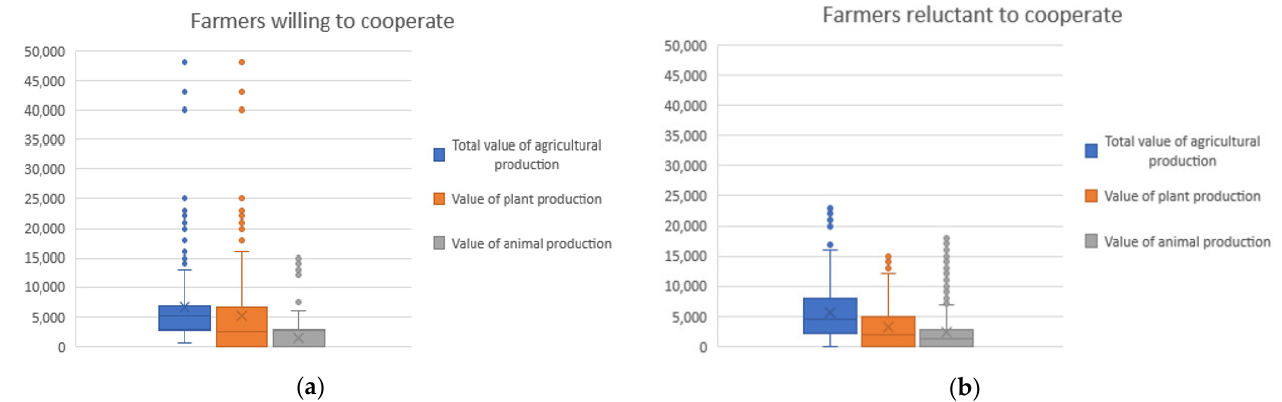
Figure 11. The value of agricultural production in groups of small-scale farms willing to cooperate ( a ) and reluctant to cooperate ( b ) (N = 1002).